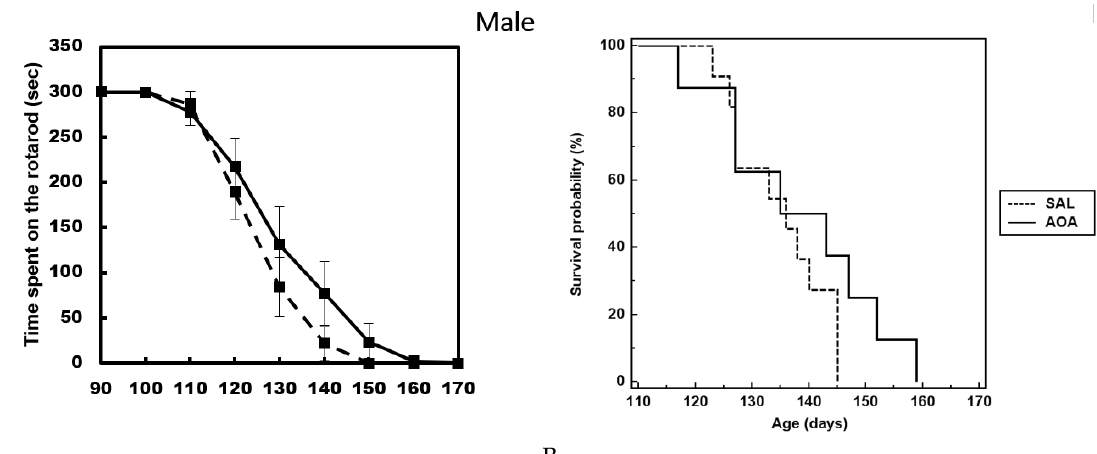
Figure 2. AOA was administered from postnatal day 75 to end-stage. ( A ) Median survival curve in Figure 1 treated with saline (140 days, n = 10) compared to females treated with AOA (154 days, n = 9). ( B ) Median survival curve in male SOD1G93A treated with saline (136 days, n = 11) compared to mice treated with AOA (139 days, n = 8). Survival curves are not significantly di ff erent. The figure also shows the time spent on the rotarod by the female ( A ) and male ( B ) groups.